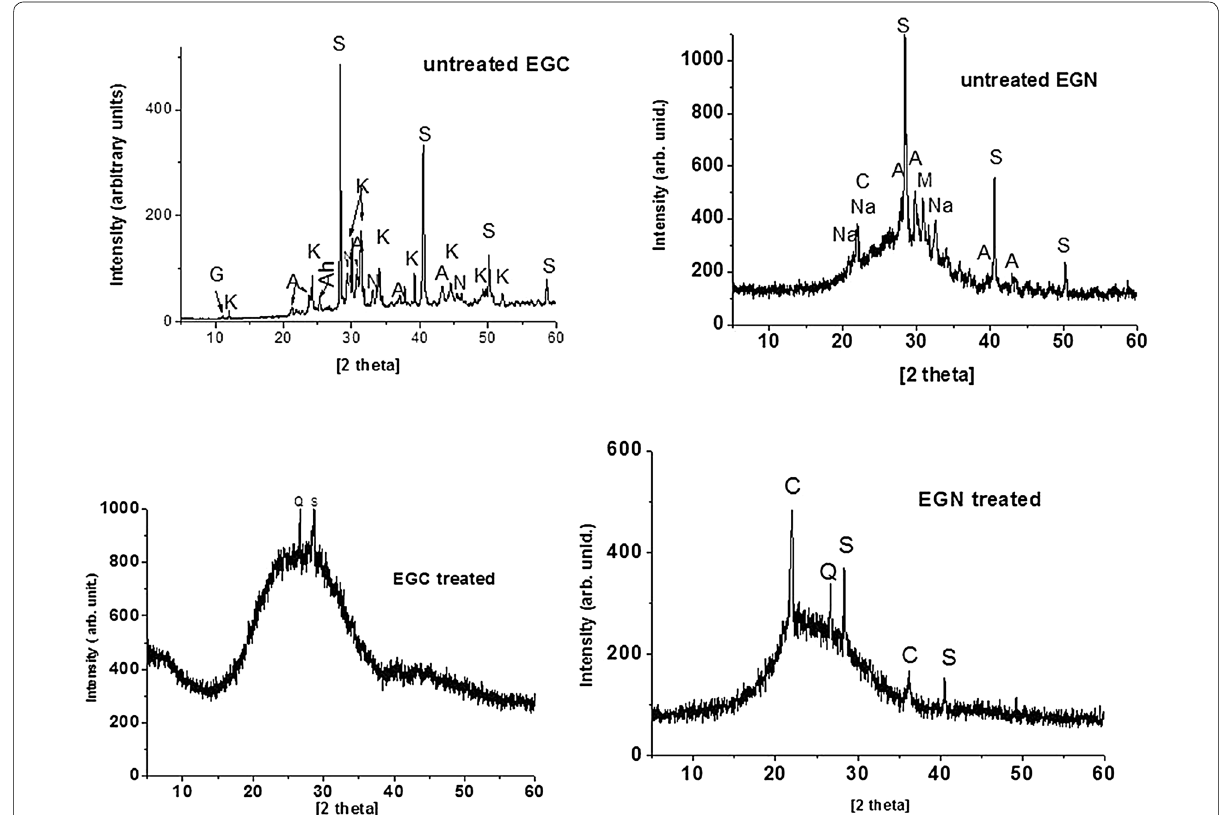
Fig. 1 XRD of EGN and EGN before and after HCl